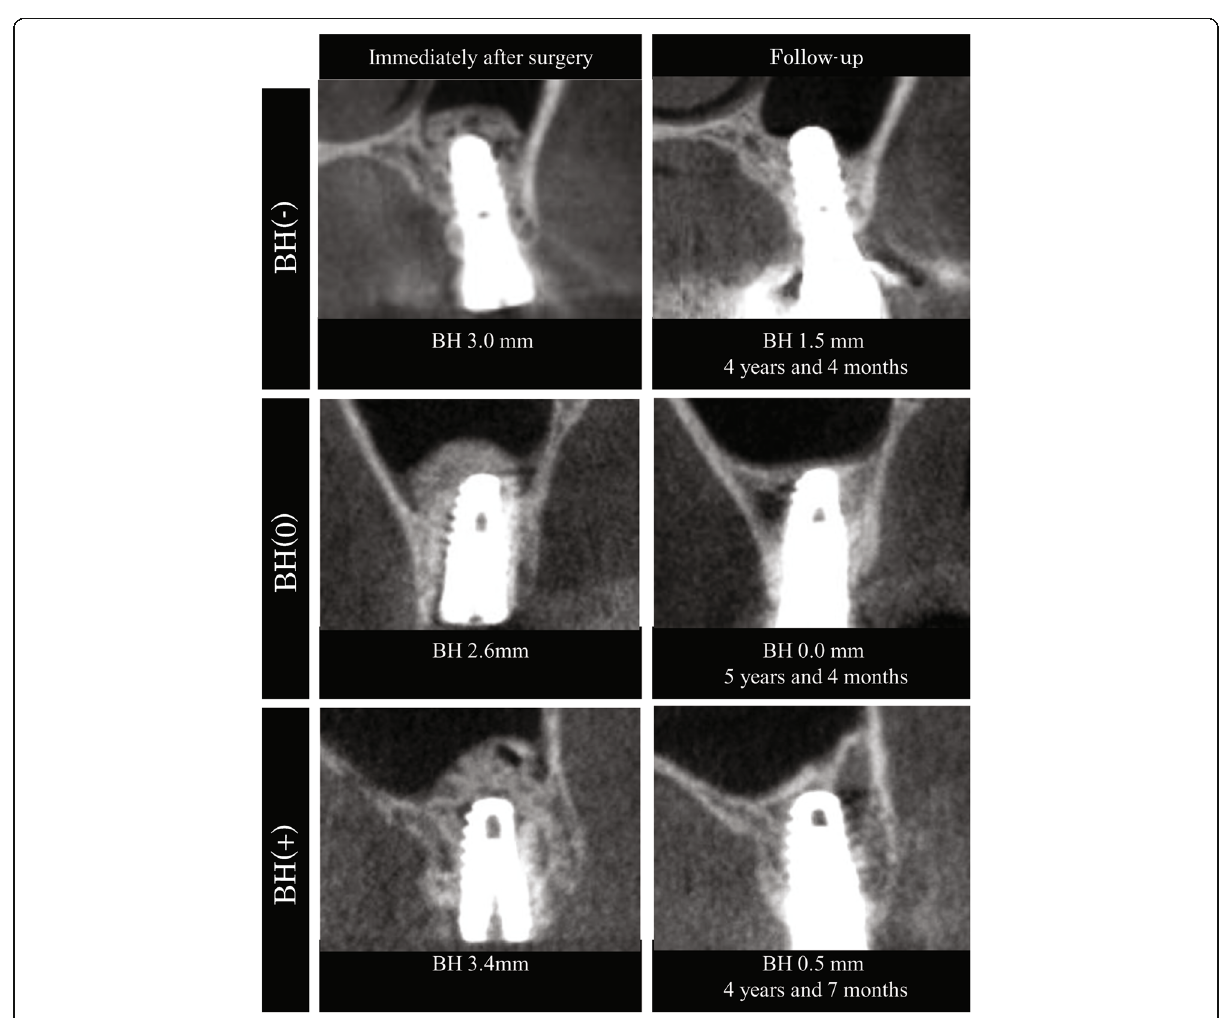
Fig. 4 CBCT images immediately after surgery and at follow-up. Immediately after surgery, the maxillary sinus floor was above the implant apex of all implants. At follow-up, the maxillary sinus floor was below the implant apex (BH < 0), at the same height (BH = 0), or above implant apex (BH > 0). BH, augmented bone above apex of the